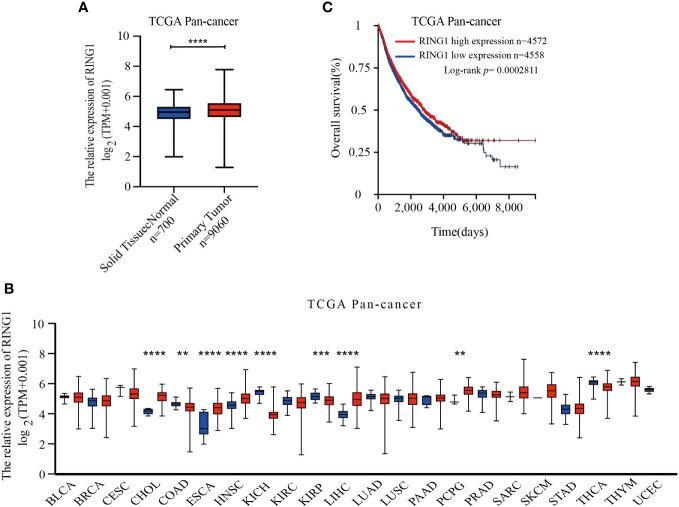
RING1 is differently expressed in human pan-cancer and is a unique prognostic factor for cancer patients. (A) RING1 mRNA level was upregulated in primary tumor group compared to normal solid tissues. (B) RING1 expression level was analyzed in human pan-cancer according to The Cancer Genome Atlas (TCGA) dataset. The red columns indicate cancer tissues, and the blue columns indicate normal tissues. (C) Kaplan–Meier survival analysis for pan-cancer by log-rank test. All the above results were obtained from the XENA website. **p < 0.01; ***p < 0.001; ****p < 0.0001.